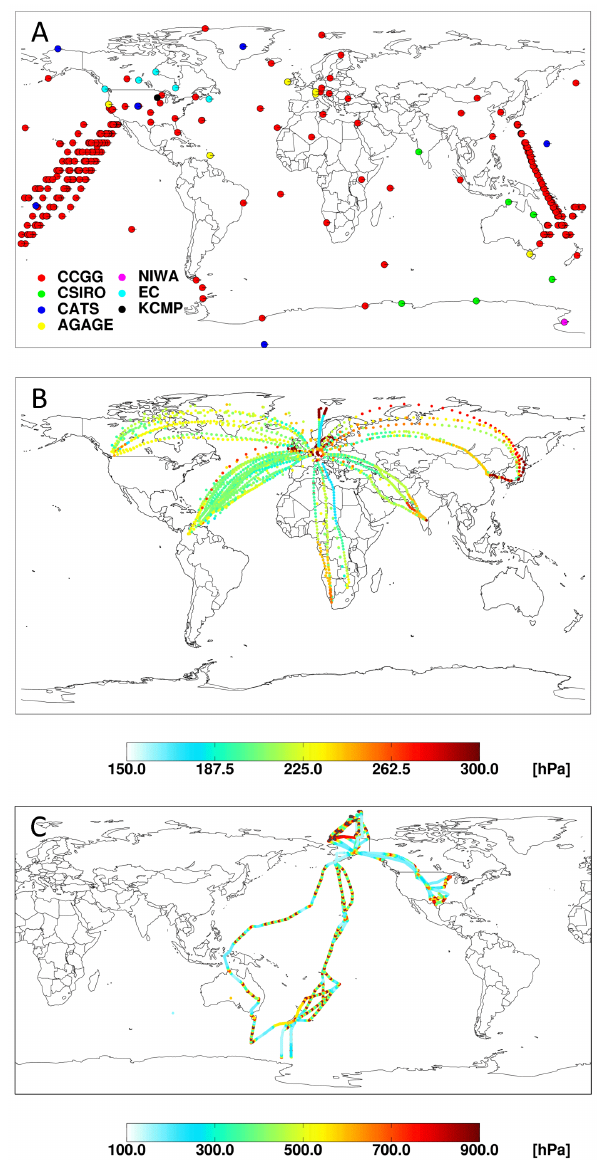
Figure 3. Global observing network for atmospheric N 2 O. Shown are the locations of (a) surface observations, (b) CARIBIC aircraft observations, and (c) HIPPO aircraft observations. The CARIBIC and HIPPO flights are shaded by the pressure at which the obser- vations were made. Color scales differ between (b) and (c) to show the range of vertical sampling in each case.